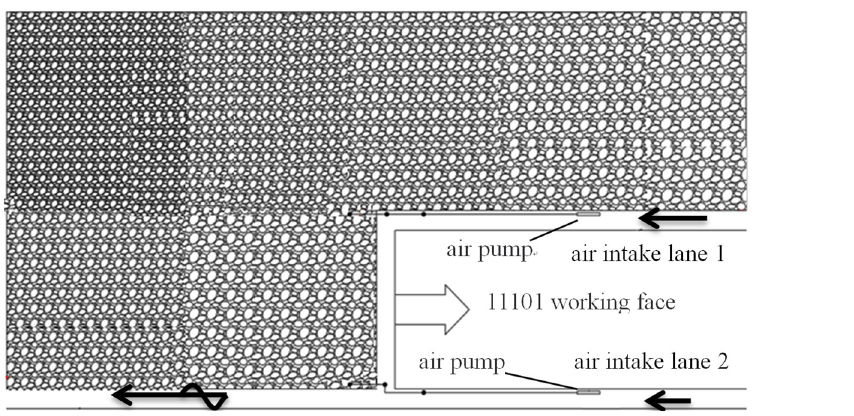
Fig 3. Schematic of the “three zone” distribution of the goaf in Qipanjing